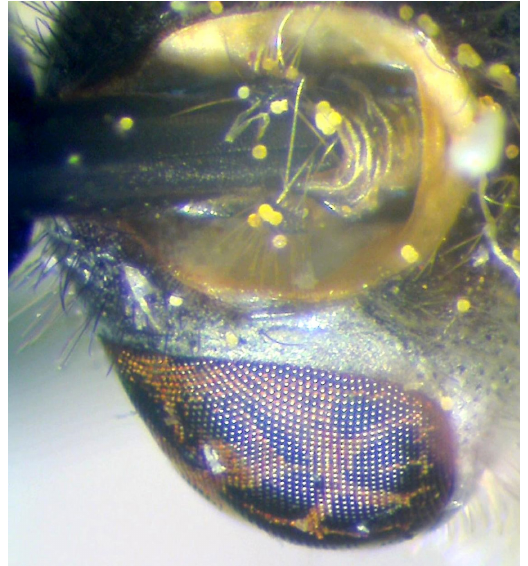
Fig. 26. Protypusia striata (Báez, 1982) gen. et comb. nov.,